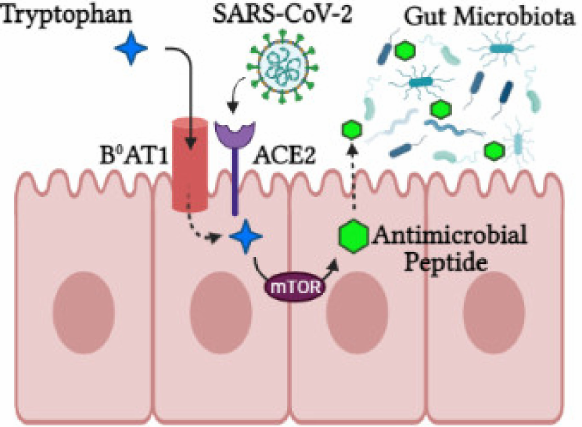
Figure 2. The role of ACE2 in the intestine. ACE2 is required for B0AT1 amino acid transporter that mediates tryptophan uptake. Tryptophan triggers antimicrobial peptide secretion via the mTOR pathway, which can alter the gut microbiota composition. Upon SARS-CoV-2 infection, ACE2 is downregulated, leading to aberrant absorption of tryptophan and antimicrobial peptides. This subsequently alters the gut microbiota, conferring susceptibility to inflammation (created with BioRender.com, accessed on 25 October